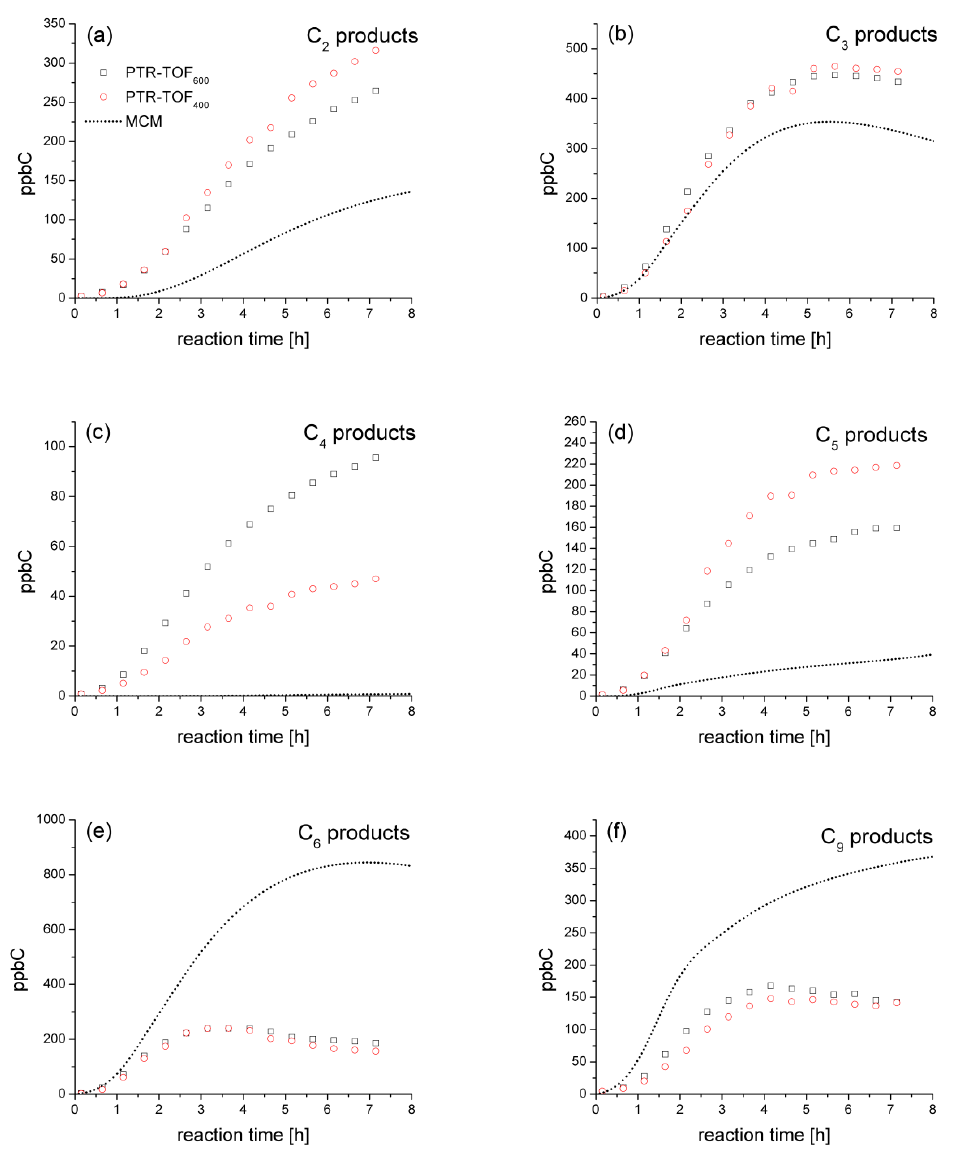
Fig. 5. Time evolution of C 2 , C 3 , C 4 , C 5 , C 6 , and C 9 TMB degradation products as measured by PTR-TOF 600 and PTR-TOF 400 and predicted by the